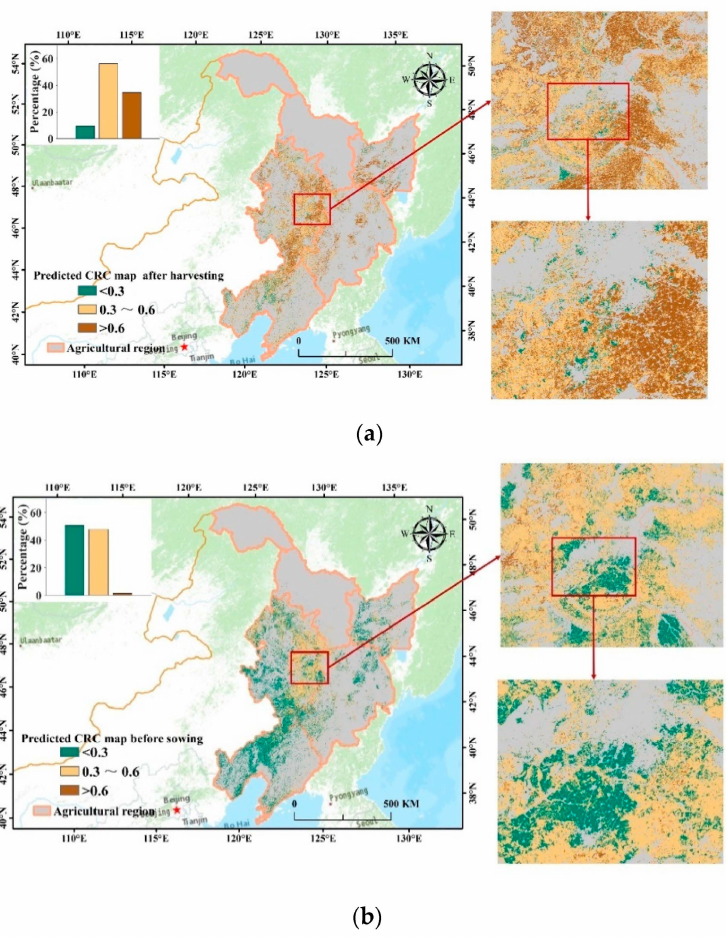
Figure 11. Predicted CRC map after harvesting ( a ) and before sowing in the next growing season ( b